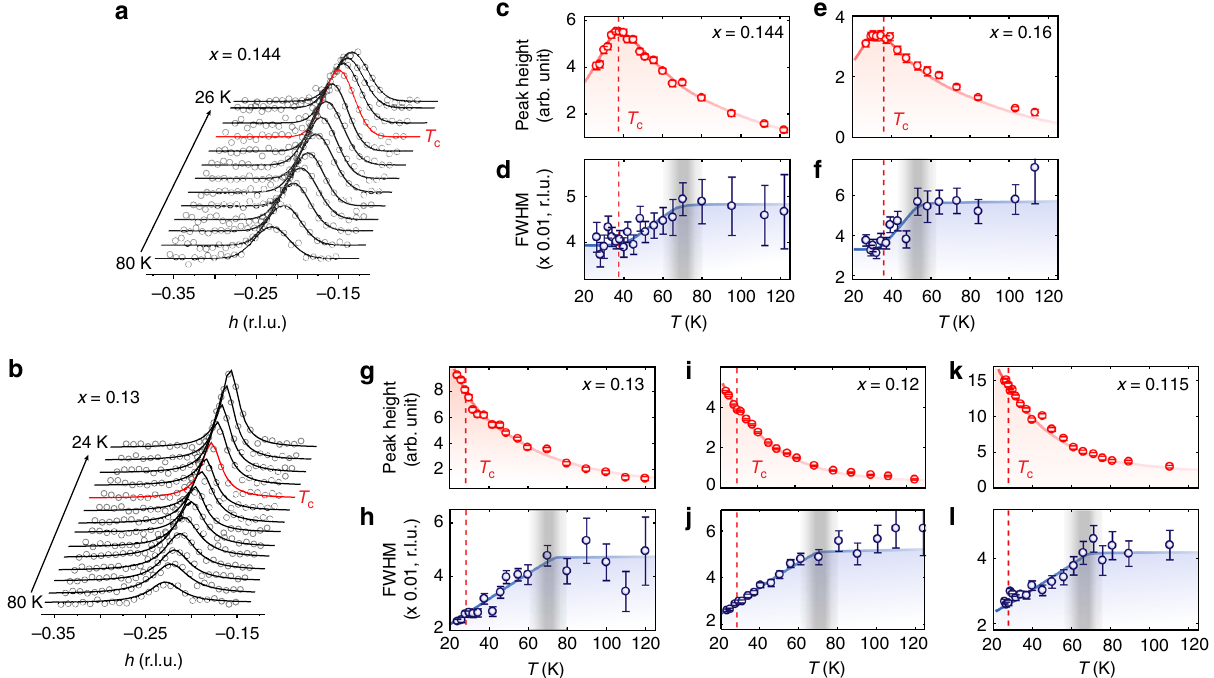
Fig. 3 Temperature dependence of the CDW order in LSCO. a , b Projected scattering pro fi les along h as a function of temperature for x = 0.144 ( a ) and 0.13 ( b ) LSCO. The solid lines are Lorentzian fi ts. The red curves denote the fi ts for data at T c . c – l Temperature dependent CDW peak heights and full- width at half-maximum (FWHM) extracted from the fi ts for various LSCO samples. The red dashed lines and vertical gray shades denote T c and T w , respectively . The colored shades and lines are guides-to-the-eye. The error bars represent 1 standard deviation (s.d.) of the fi t parameters. Source data are provided as a Source Data fi